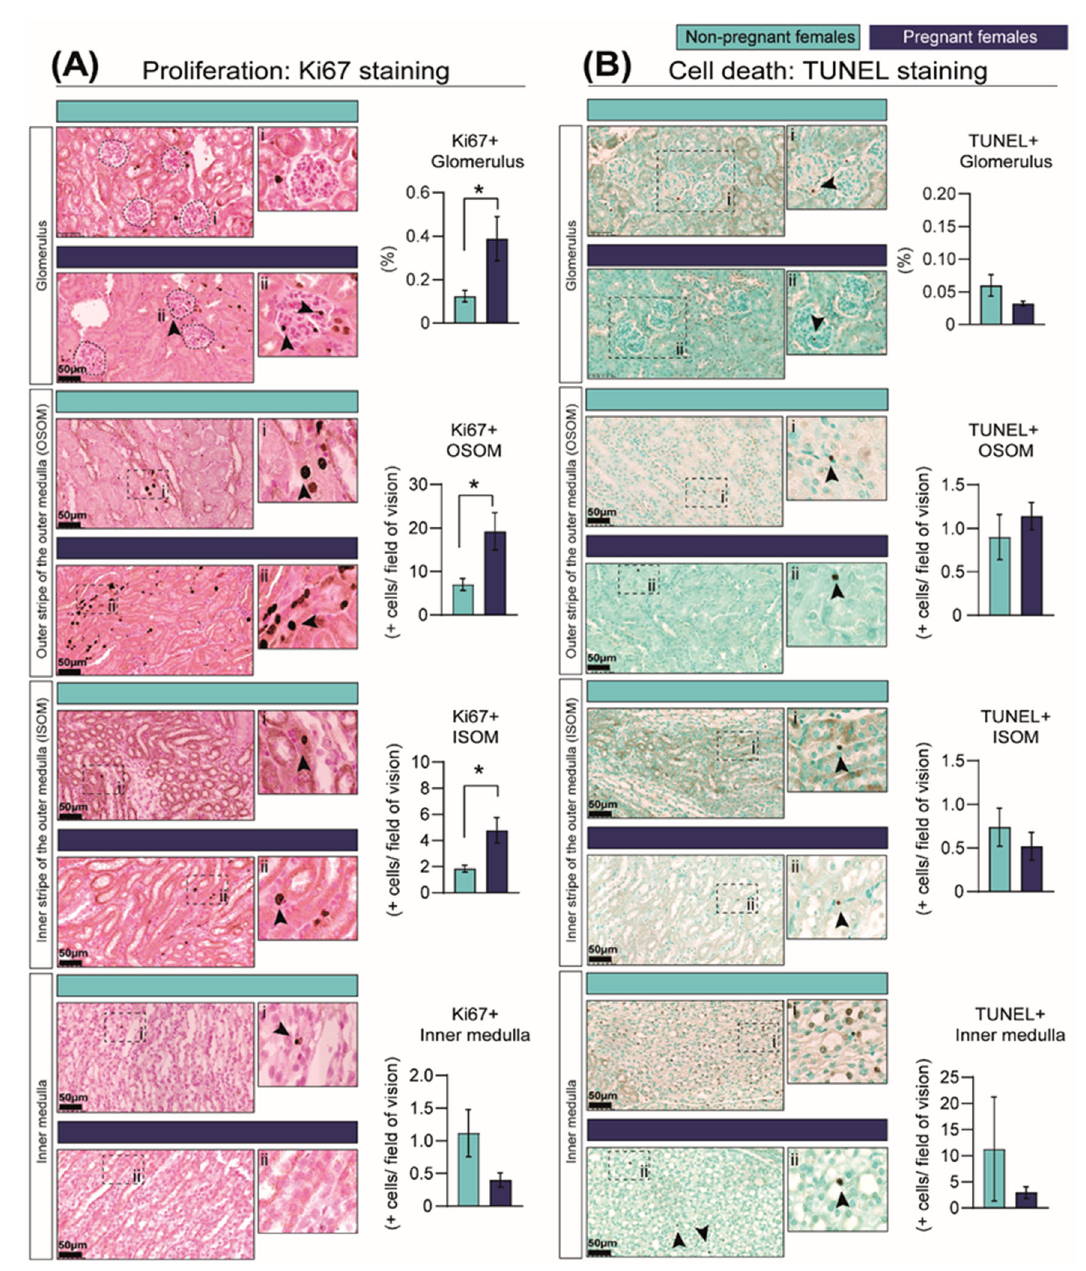
Figure 3. Percentage of cells showing cell ‐ cycle activation as informed by Ki67 immunostaining (A) and cell death as identified by TUNEL assay (B) in the kidney in response to pregnancy in mice. Representative image of stained kidney from non ‐ pregnant and pregnant female mice. Data are presented as mean ± SEM (n = 5/group). Asterisks represent significant differences between non ‐ pregnant and pregnant mice as determined by Student’s t ‐ Test (* p < 0.05). Images with the labels i and ii depict high magnification of the selected area. Arrow heads indicate positive DAB staining. Scale bar is 50 μ m.